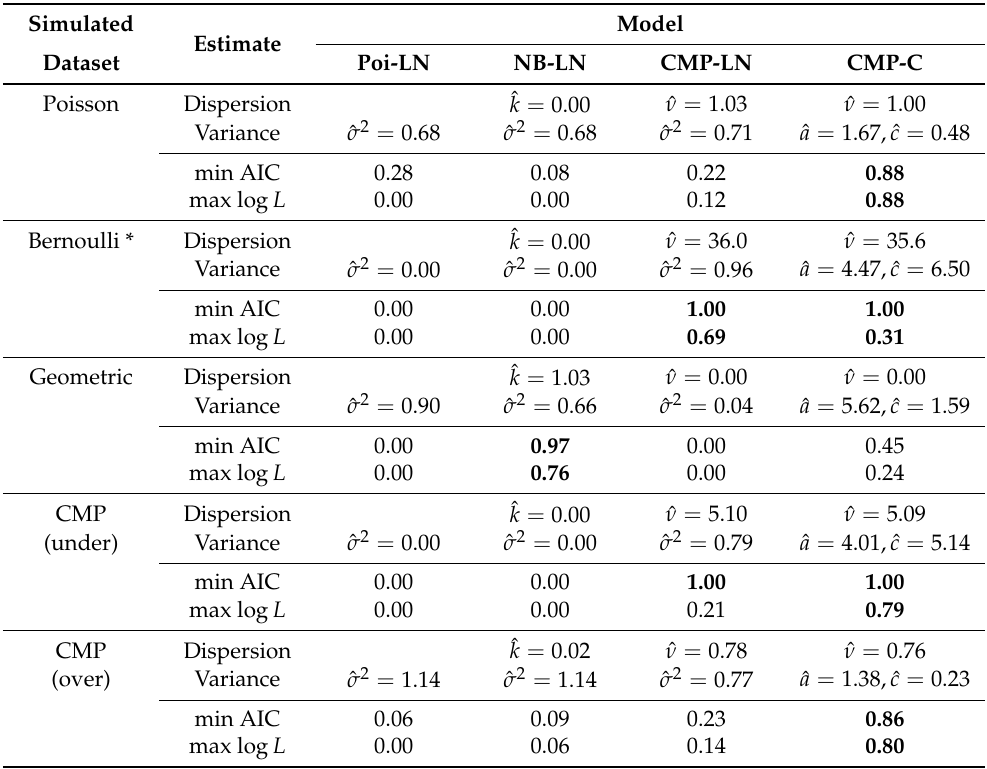
Table 2. Average of dispersion and variance estimates, and model fit measures for simulated data in Scenario II. Model fit measures: min AIC is proportion of 50 replications where AIC ≤ min(AIC) + 2, and max log L is proportion of 50 replications where log L is largest. Bold values indicate model with largest proportion of min AIC or max log L